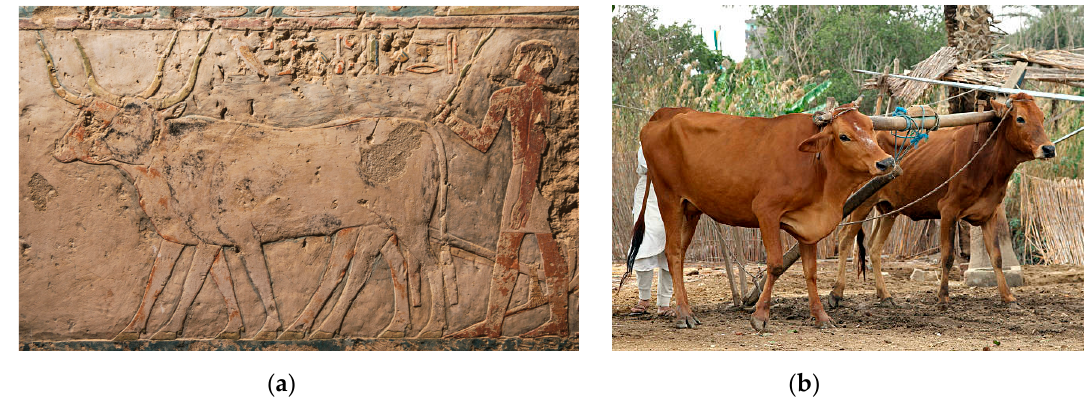
Figure 3. ( a , b ) Domesticated cattle ( Bos taurus ) ploughing the field from the 12th Dynasty tomb of Senbi (B1) at Meir (left), and modern Egyptian cattle in a parallel setting (right). Left image source: Kanawati and Evans (2017, pl. 32(b)). Right image source: Username, ttaty, ‘Domestic cows’, on iStock.